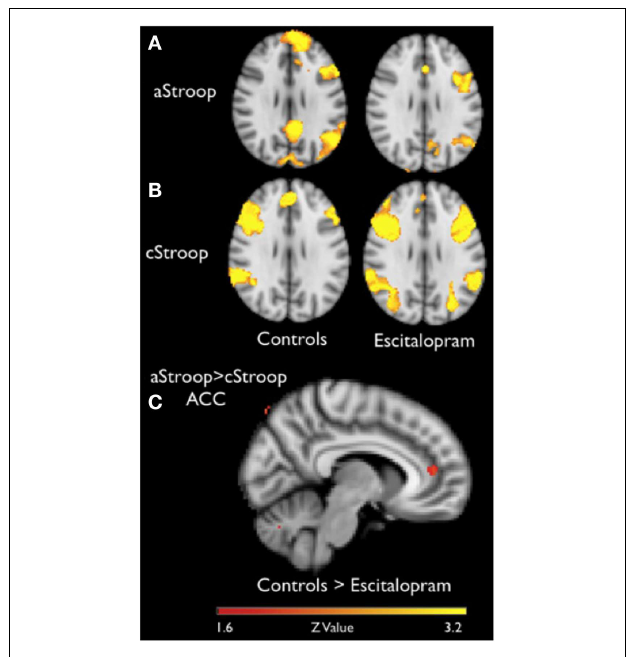
FIGURE 2 | fMRI results . (A,B) Brain activation during affective counting Stroop (aStroop) and cognitive counting Stroop (cStroop), before (controls) and after intake of escitalopram (cluster forming threshold Z ≥ 2.3, corrected p = 0.05, MNI z = 29). In both Stroop conditions, there are significant activations in anterior cingulate cortex (ACC) and dorsolateral prefrontal cortex, key nodes in the neural cognitive control networks. (C) A region of interest analysis of the ACC, where aStroop activates more than cStroop before compared to after drug intake. For display purposes the cluster shown in the image has an uncorrected threshold of 0.005, but the peak voxel ( x , y , z : 6, 44, 12) survived a corrected threshold of p = 0.05 (at the voxel level, using Gaussian random field